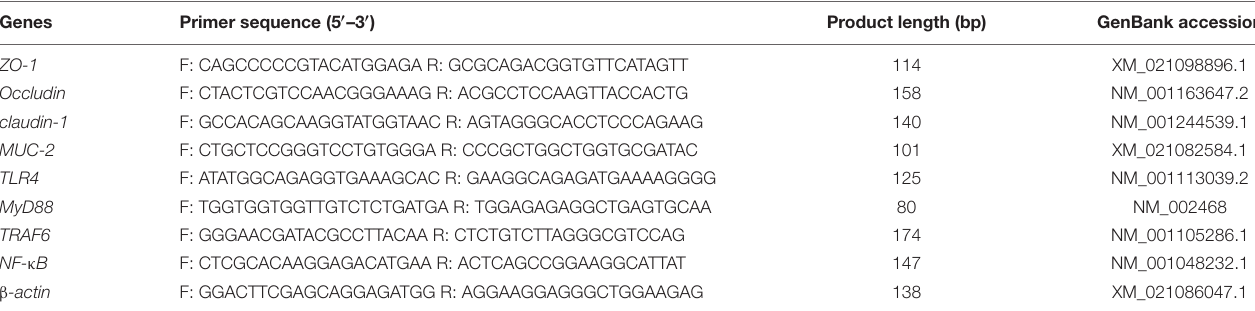
TABLE 3 | Primers sequences for RT-qPCR. Genes Primer sequence (5 (cid:48) –3 (cid:48)